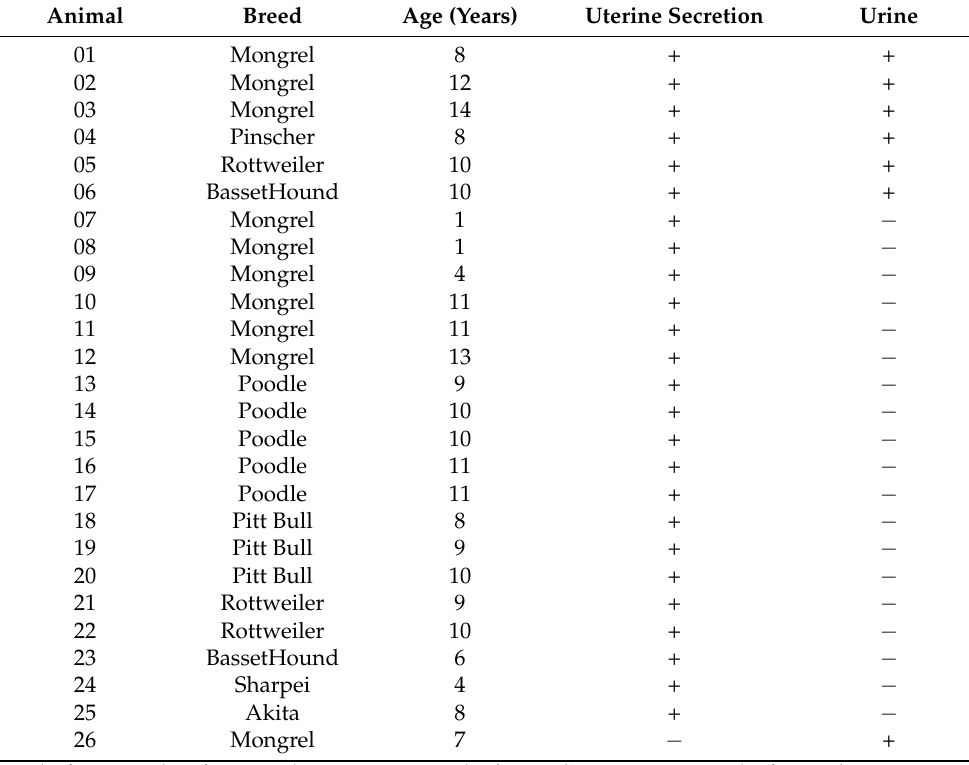
Pitt Bull + + + − 23 BassetHound 6 + − 24 Sharpei 4 + − 25 Akita 8 + − 26 Mongrel 7 −